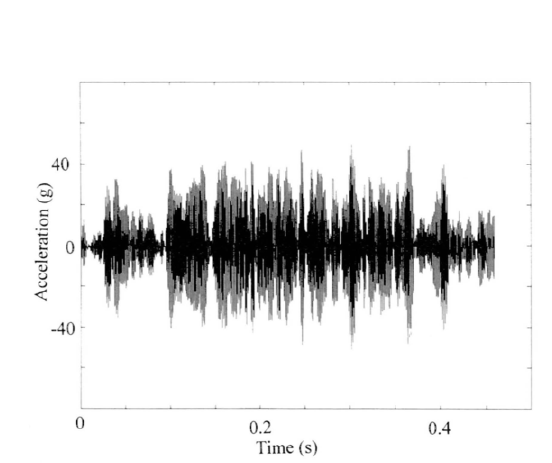
FIGURE 14 Response of a 661-Hz SDOF system with 5% damping to the input time history of Fig. 5.